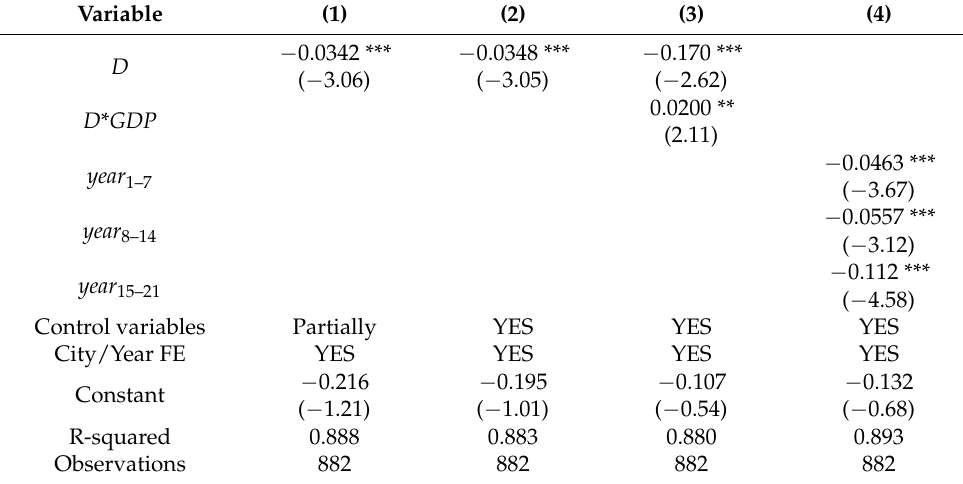
Table 3. Benchmark regression